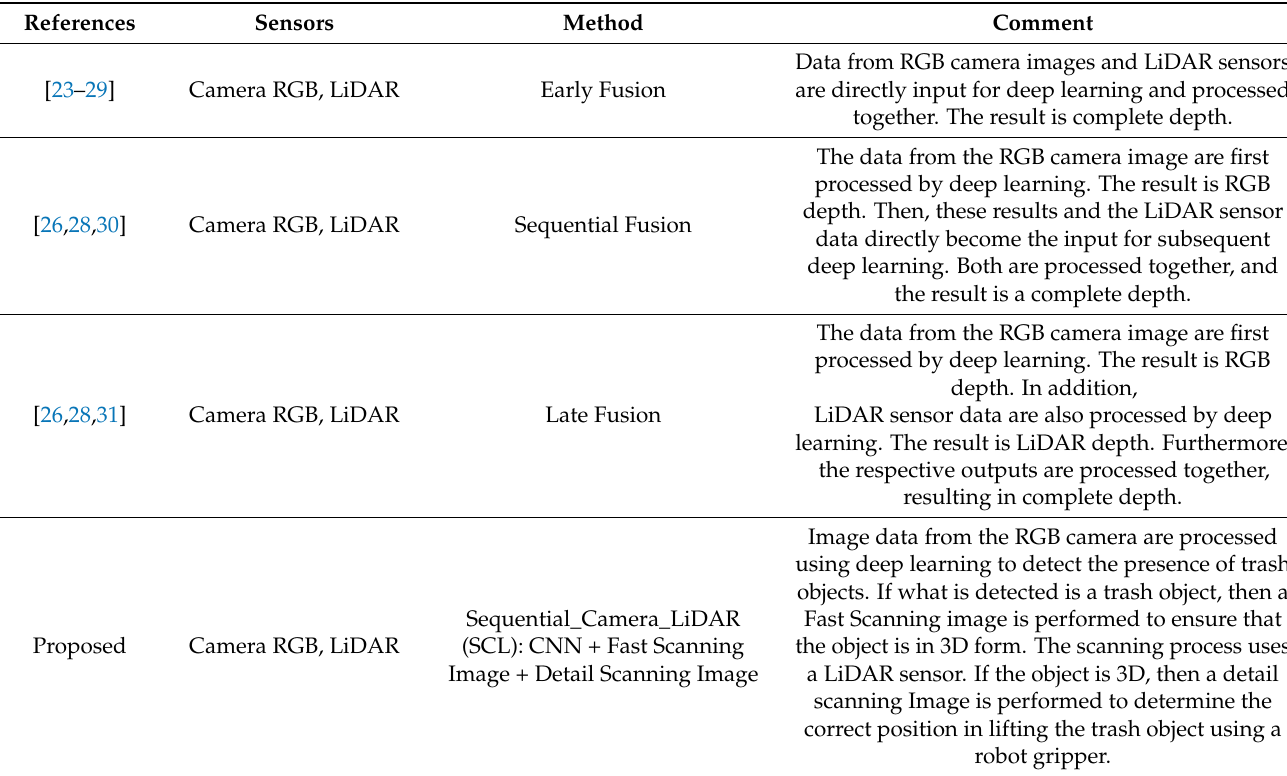
Table 1. Comparison between the Sensor Fusion Method and the Proposed